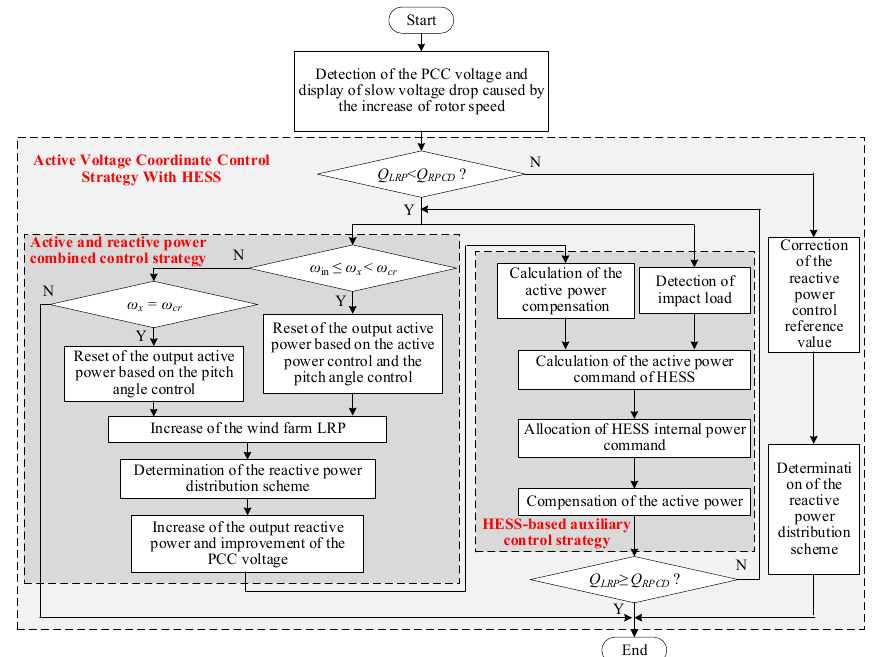
Figure 4. The structure of the active voltage coordinate control